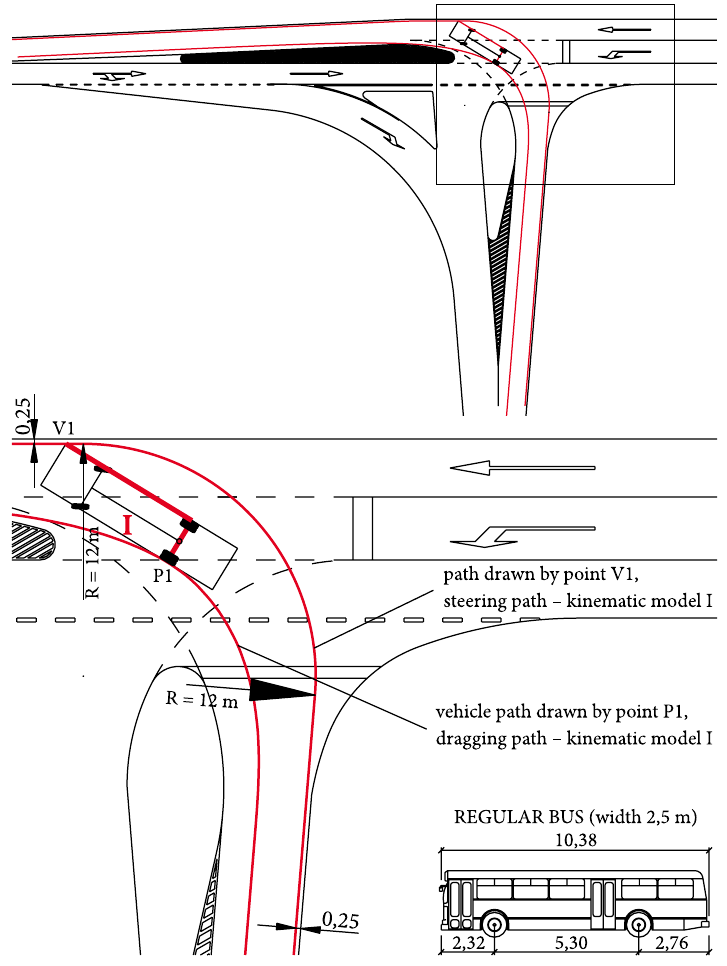
fig. 4. Setting vehicle movement trajectory – kinematic model